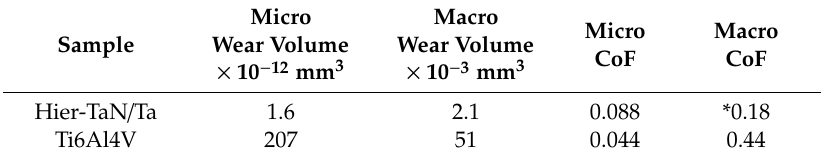
Table 2. Summary of the main results obtained from the micro and macro-tribological tests of the coatings and substrate. * CoF (friction coe ffi cient) obtained until the 540 s without